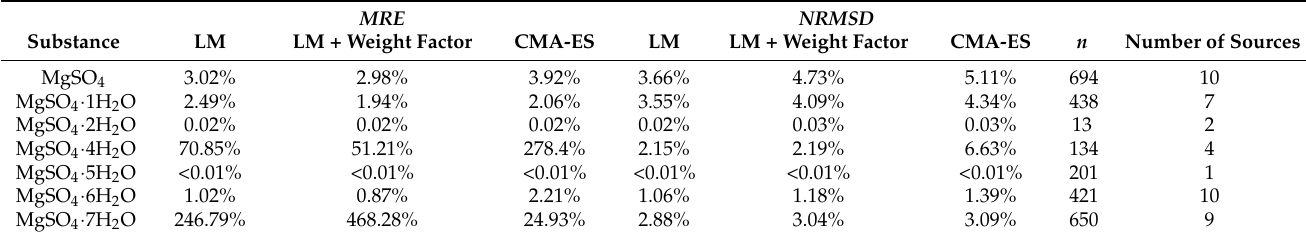
Table 7. Statistical error and deviations of the fitted heat capacity with different fitting methods, n is the number of compared points or population.